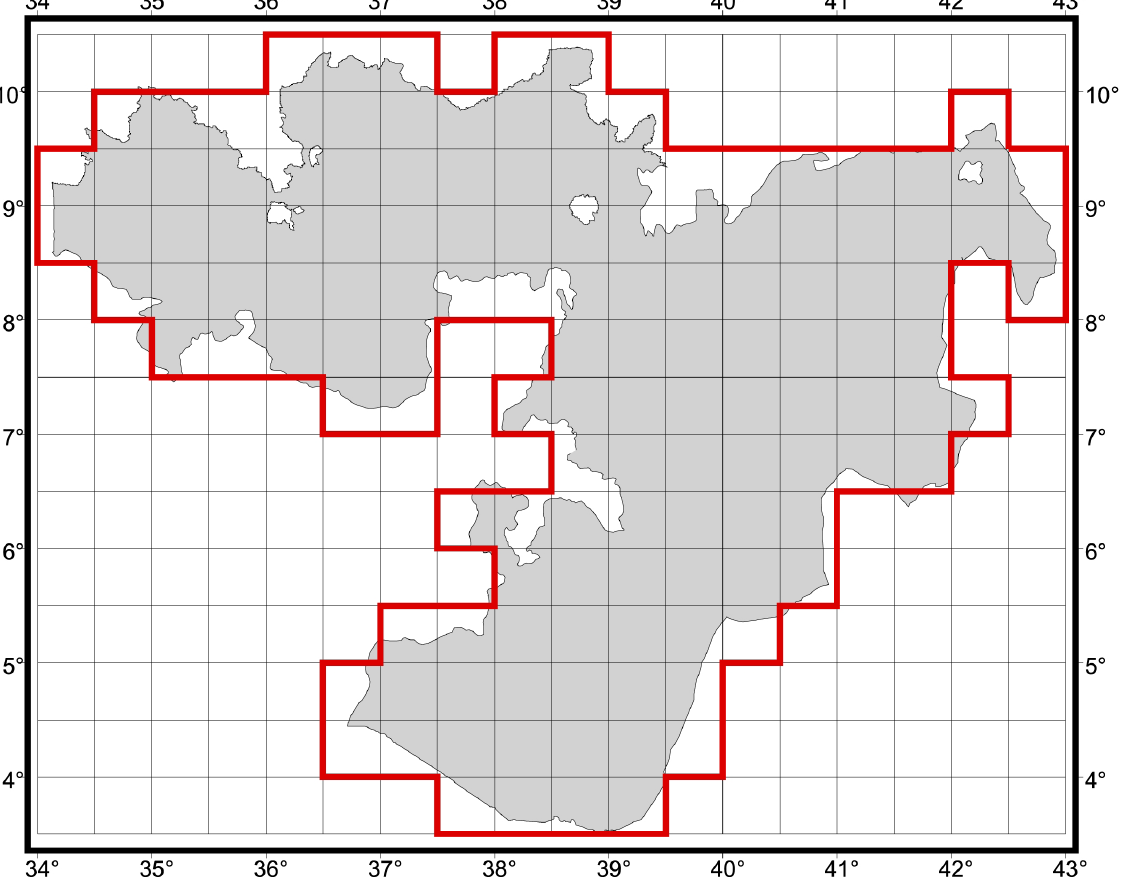
Fig. 3. The National Regional State of Oromia covered by 1-degree-tetrads. For the bold-red framed tetrads the data on distribution of birds was taken from the distribution atlas of Ash & Atkins